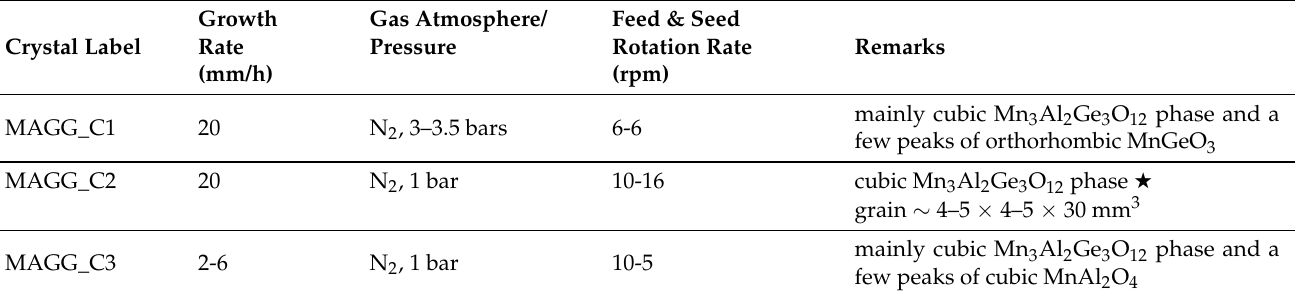
Table 2. Summary of the conditions used for the growth of the Mn 3 Al 2 Ge 3 O 12 garnet crystal boules a